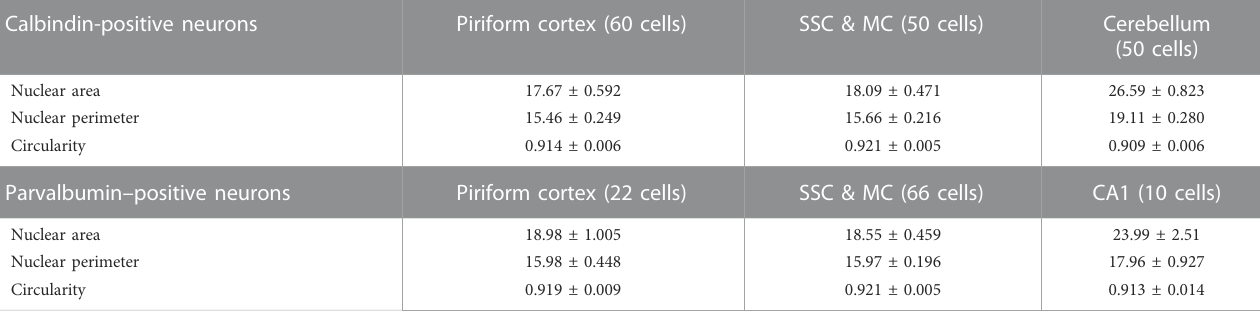
TABLE 2 Nuclear area, perimeter, and circularity of calbindin-positive and parvalbumin-positive neurons. Calbindin-positive